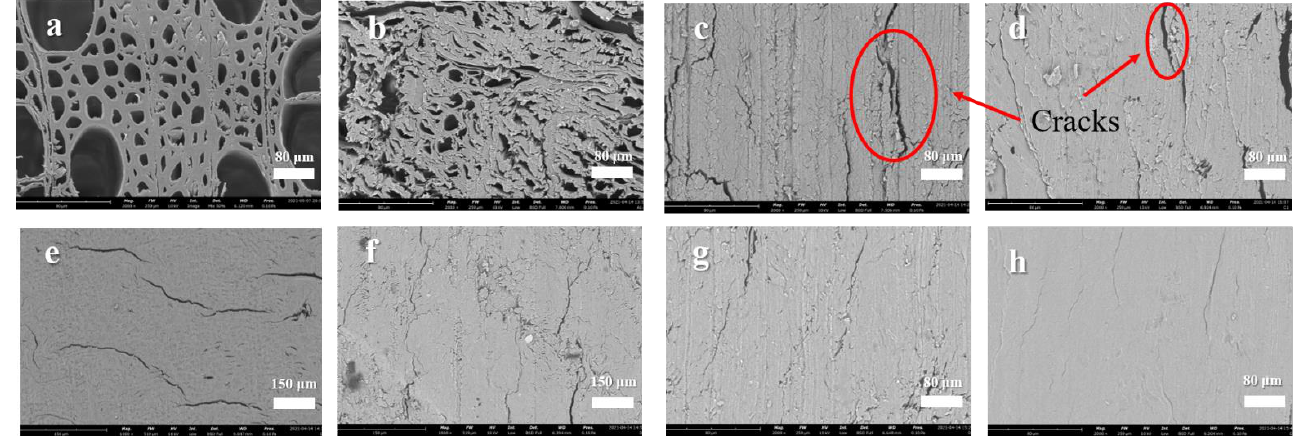
Figure 2. Comparison of microscopic characteristics: ( a ) untreated wood, ( b ) direct hot-pressing wood, ( c ) delignified hot-pressing wood, ( d ) DC-P, ( e ) DC-SP-1, ( f ) DC-SP-1K, ( g ) DC-SP-5, ( h ) DC-SP-5K.